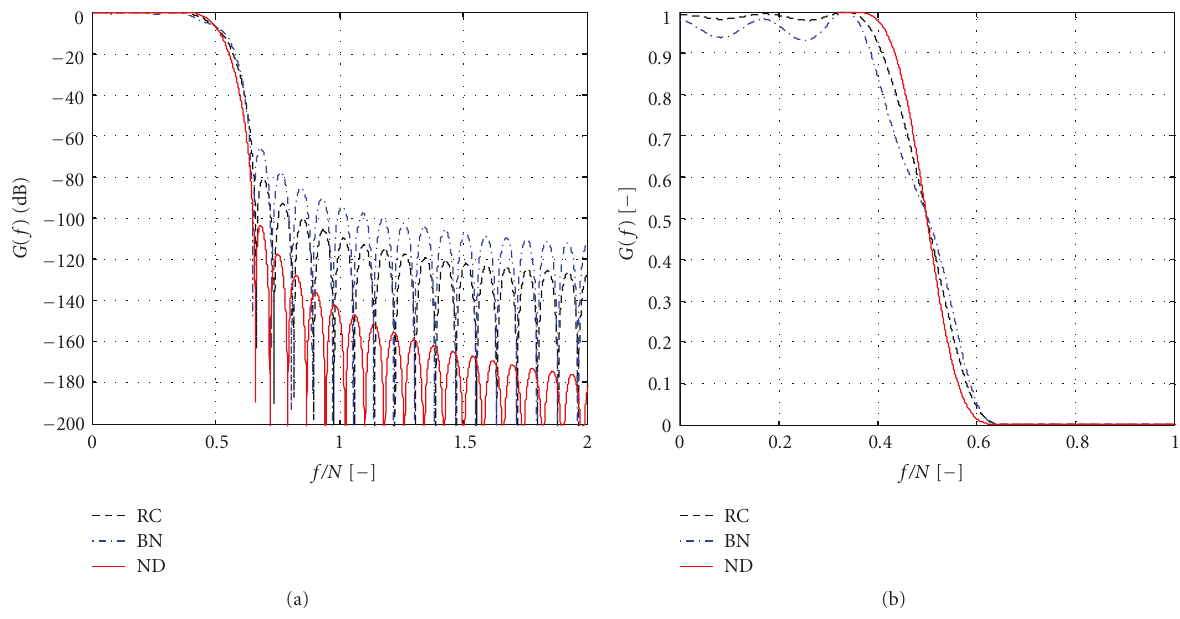
Figure 9: (a) Amplitude frequency characteristics of the cascade of transmitter and receiver RC filter (RC); B -filter (BN); Nyquist δ -filter (ND) of the same filter order and equivalent excess bandwidth α = 0 . 284; G D = 2 × 6; N = 5; N O = 2 × 60. (b) Amplitude frequency characteristics plotted in linear scale.